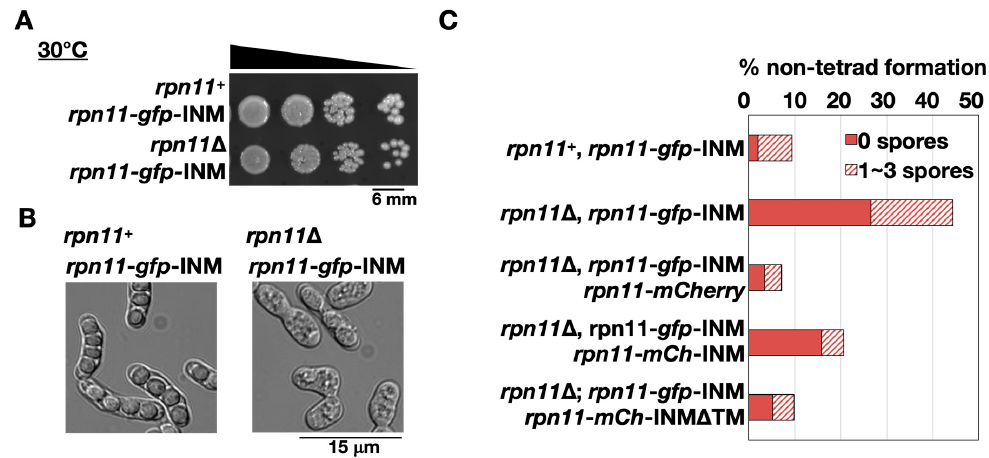
Figure 3. Abnormal ascospore formation in the rpn11-gfp-INM cells. ( A ) Spot assay of the yeast cells’ vegetative growth expressing Rpn11-GFP-INM in the presence or absence of endogenous rpn11 + . The samples (around 10 6 cells/mL) were 10-fold serial diluted and spotted on the yeast extract with supplement (YES) plate. The plate was incubated at 30 °C for four days. ( B ) Microscopy observation of the yeast sporulation after three days on the malt extract (ME) plate. ( C ) Non-tetrad formation frequency of the cells expressing Rpn11-GFP-INM or co-expressing Rpn11-GFP-INM and the other Rpn11-fusion proteins. Non-tetrad was classified into two groups: the ascus containing 0 spores (solid bar) or 1–3 spores (striped bar). (% of non-tetrad formation = the number of asci containing non-tetrad/the total number of asci).